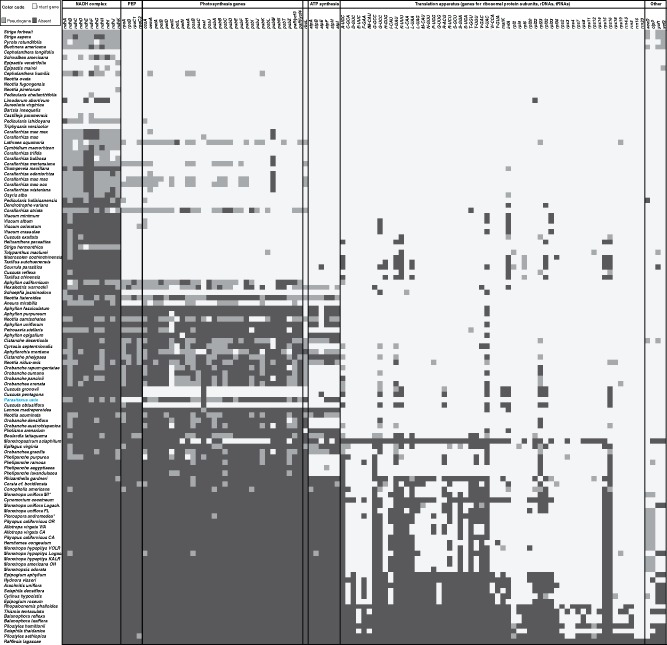
—Plastid coding capacities of Parasitaxus and other heterotrophic land plants. The presence and absence of plastid genes across all currently studied plastomes of heterotrophic plants compiled by Wicke and Naumann (2018) and all data published since (full list of included data: supplementary table S4, Supplementary Material online) is depicted for all plastid gene classes. Not included here are the chl genes, which have been lost ancestrally in angiosperms, unrelated to heterotrophy (Wicke et al. 2011). Parasitaxus is highlighted in blue. Offwhite and light gray indicate the presence of specific genes as intact or pseudogene, whereas the absence of a gene from a plastome is marked in dark gray. Heterotrophic plant species are sorted by decreasing plastome size (from top to bottom).